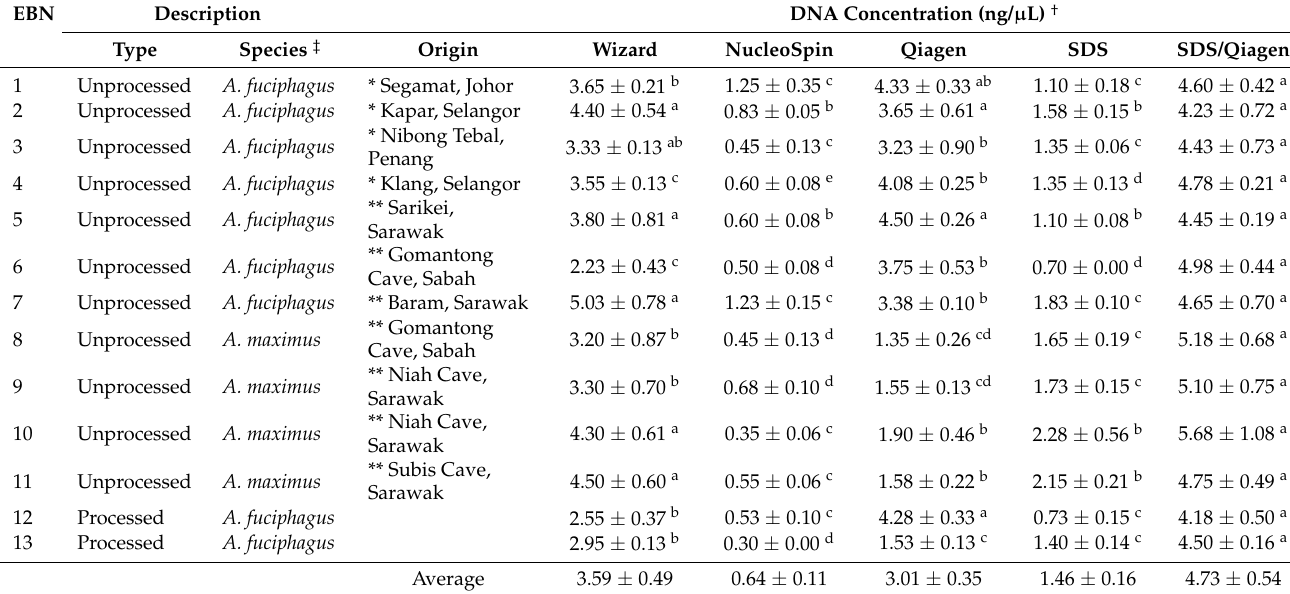
Table 1. DNA concentration of EBN samples extracted with five DNA extraction methods as measured by spectrophotometry.